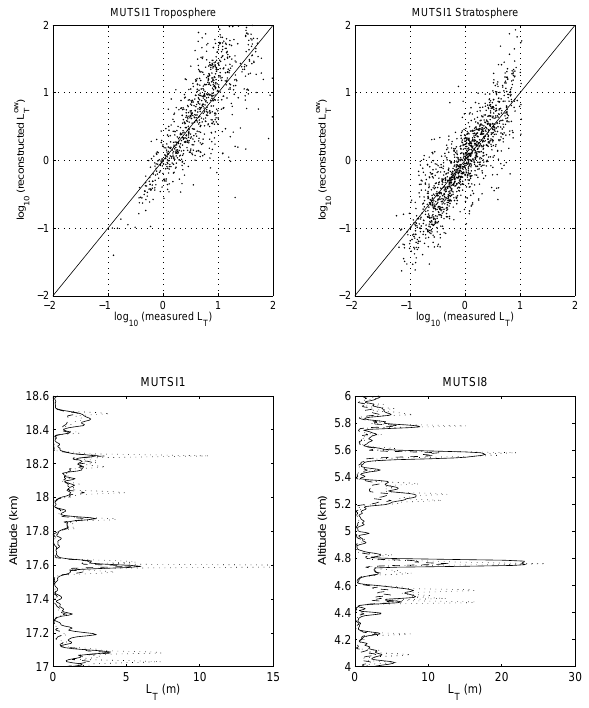
Figure 8. Thorpe lengths directly measured and reconstructed with (15) (top left) for flight M1 for the Fig. 8. Thorpe lengths directly measured and reconstructed with troposphere (left) and stratosphere (top right), also directly measured (solid lines), reconstructed with (13) (dashes) and reconstructed with (15) (dots) for the same ranges as in Figure 3 (bottom left) and Eq. (15) (top left) for flight M1, for the troposphere (left) and strato- Figure 4 (bottom right). sphere (top right), also directly measured (solid lines), reconstructed with Eq. (13) (dashes) and reconstructed with Eq. (15) (dots) for the same ranges as in Fig. 3 (bottom left) and Fig. 4 (bottom